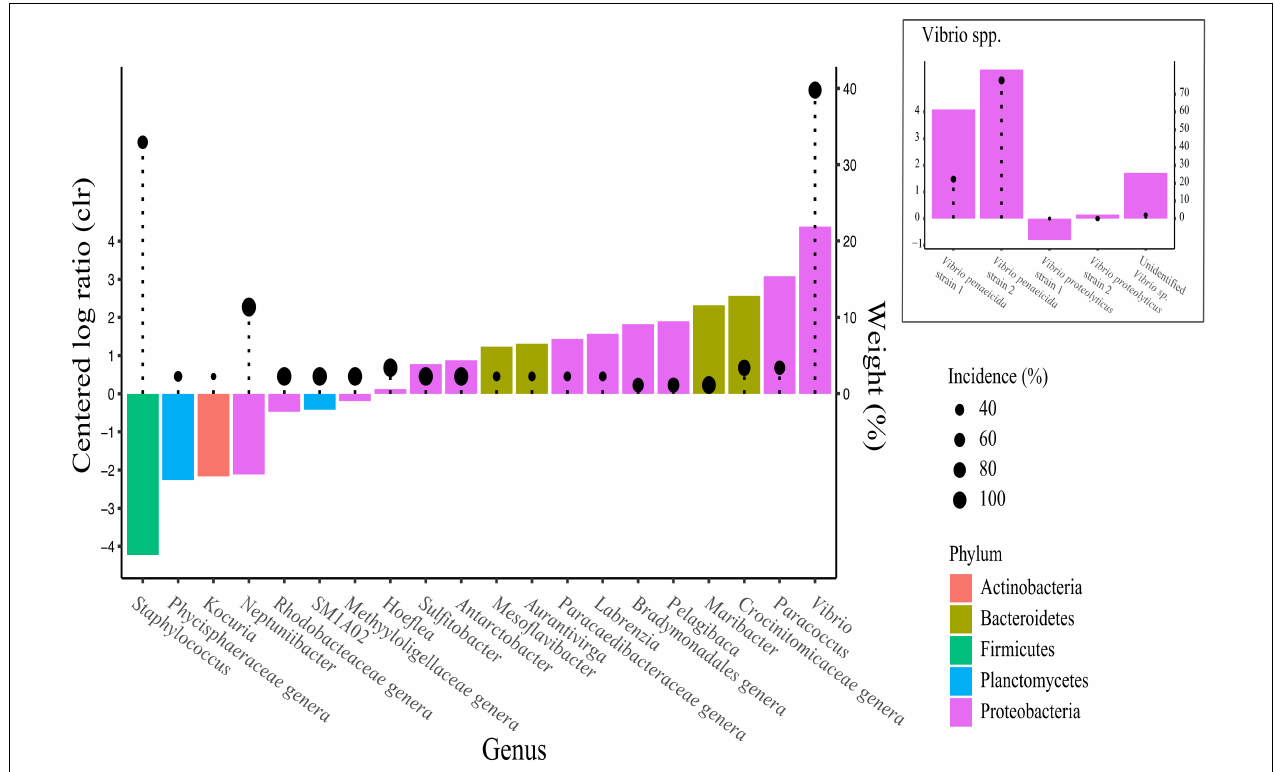
FIGURE 10 | Analysis of composition of microbiomes (ANCOM) of the different taxa between algal feeding ration treatment using the centered log ratio (clr) abundance at genus level. Taxa more abundant under low ration have negative values and vice versa. Weights displayed by lollipops represent the percentage of significant pairwise analyses testing differences in taxa abundance between treatments using each other taxa as denominator. Taxa with higher weights are more likely to be truly affected by the